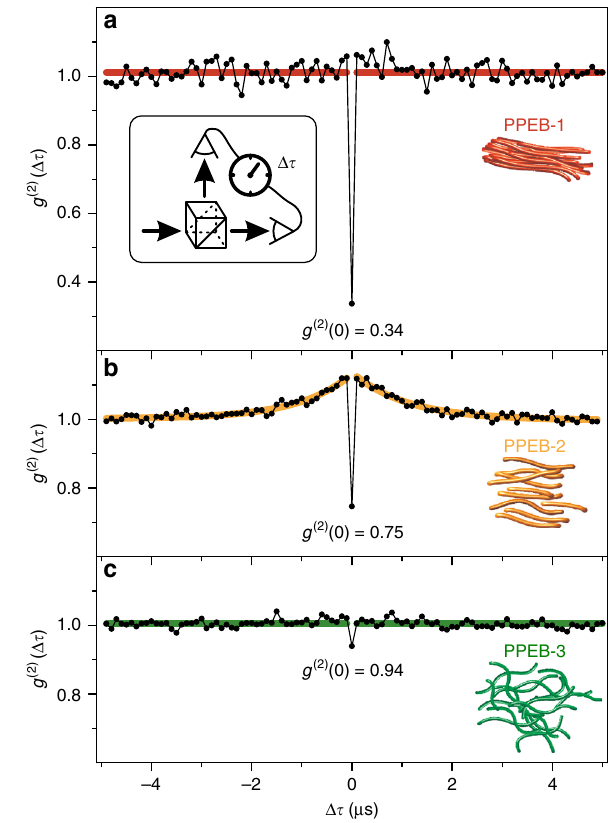
Fig. 7 Photon statistics of single multichain aggregates measured in air. Accumulated second-order cross-correlation, g (2) ( Δ τ ), curves for 57 PPEB- 1 a , 47 PPEB-2 b , and 44 PPEB-3 c aggregates. The aggregates were excited by laser pulses (10 MHz repetition rate) to control the difference Δ τ in photon arrival time between the two detectors. The antibunching dip at Δ τ = 0 is apparent. In b , photon bunching occurs for Δ τ j j > 0, which is described by a single-exponential fi t Fig. 7a. The red line is a guide to the eye and demonstrates that no photon bunching occurs on the microsecond time scale (i.e., g 2 ð Þ Δ τ ≠ 0 ð Þ (cid:4) 1), implying the absence of long-lived dark states